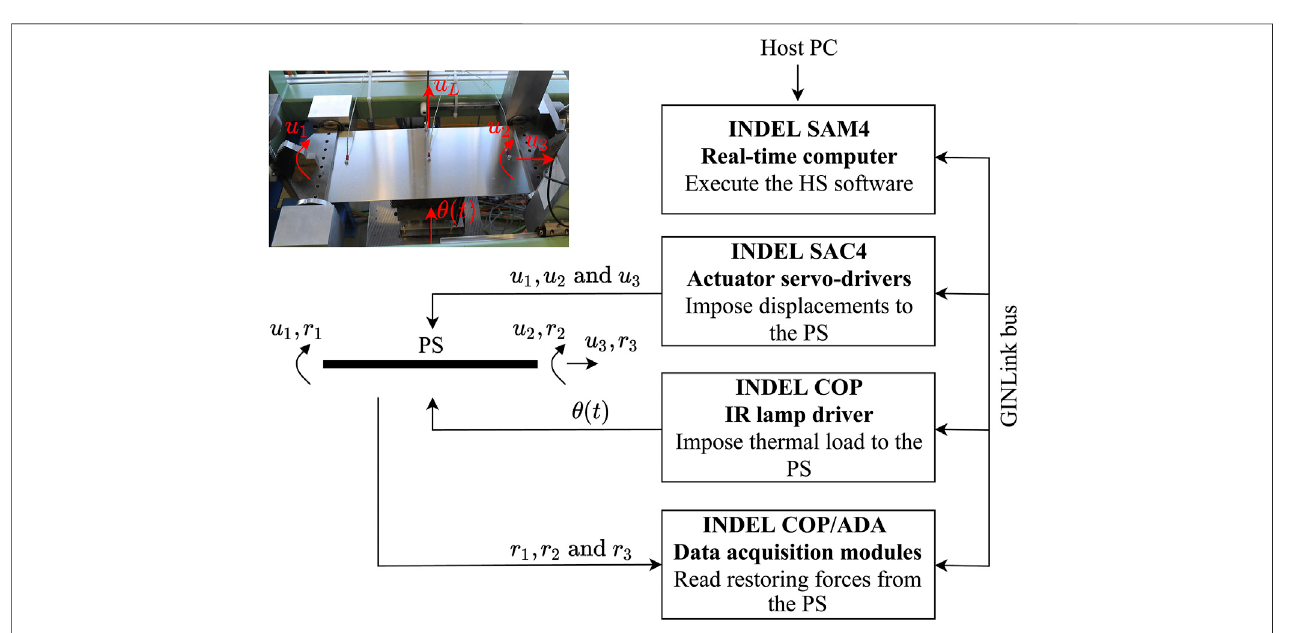
FIGURE 3 | Architecture of the 3-DoF HS test